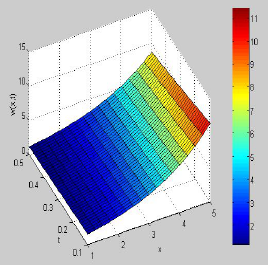
Fig. 8: Surface graph of w ( x , t ) of eq. (8.4), when α = 1